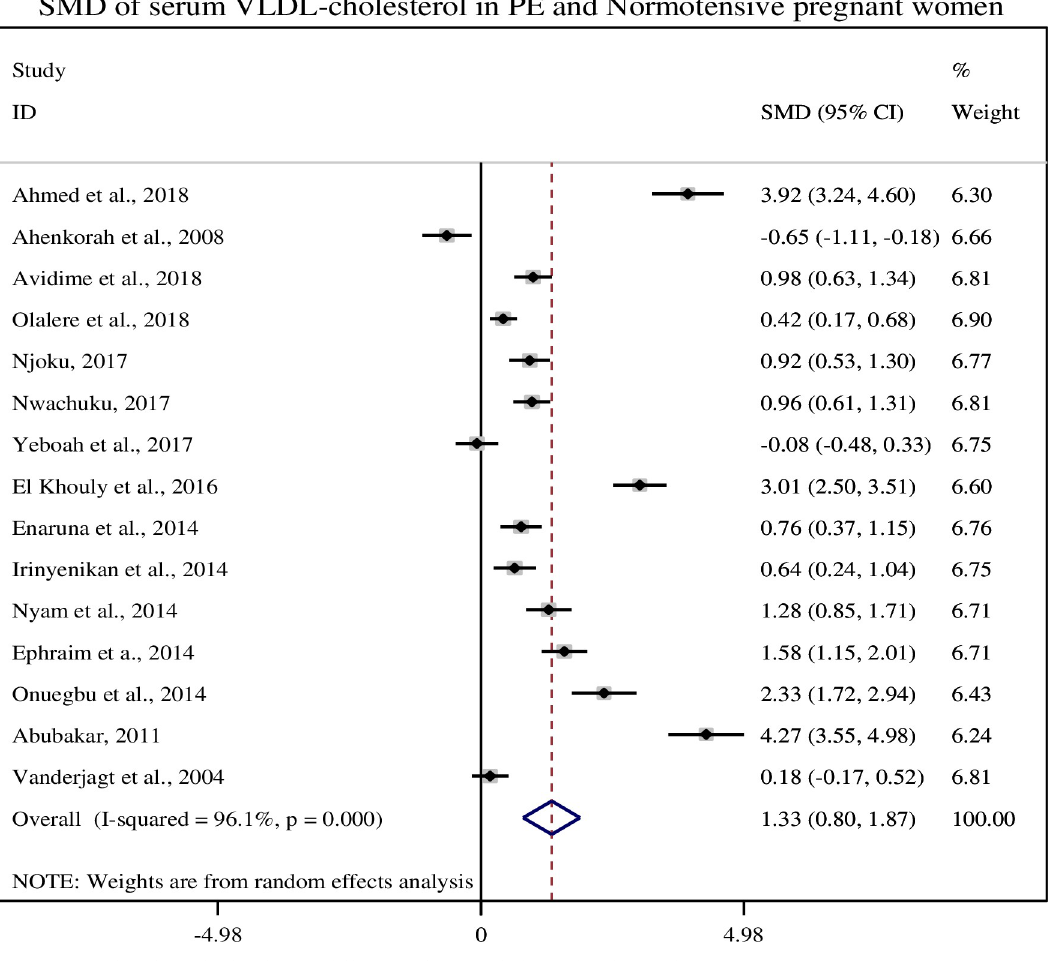
Fig 6. Forest plot of standardized mean difference of VLDL-cholesterol and pre-eclampsia.